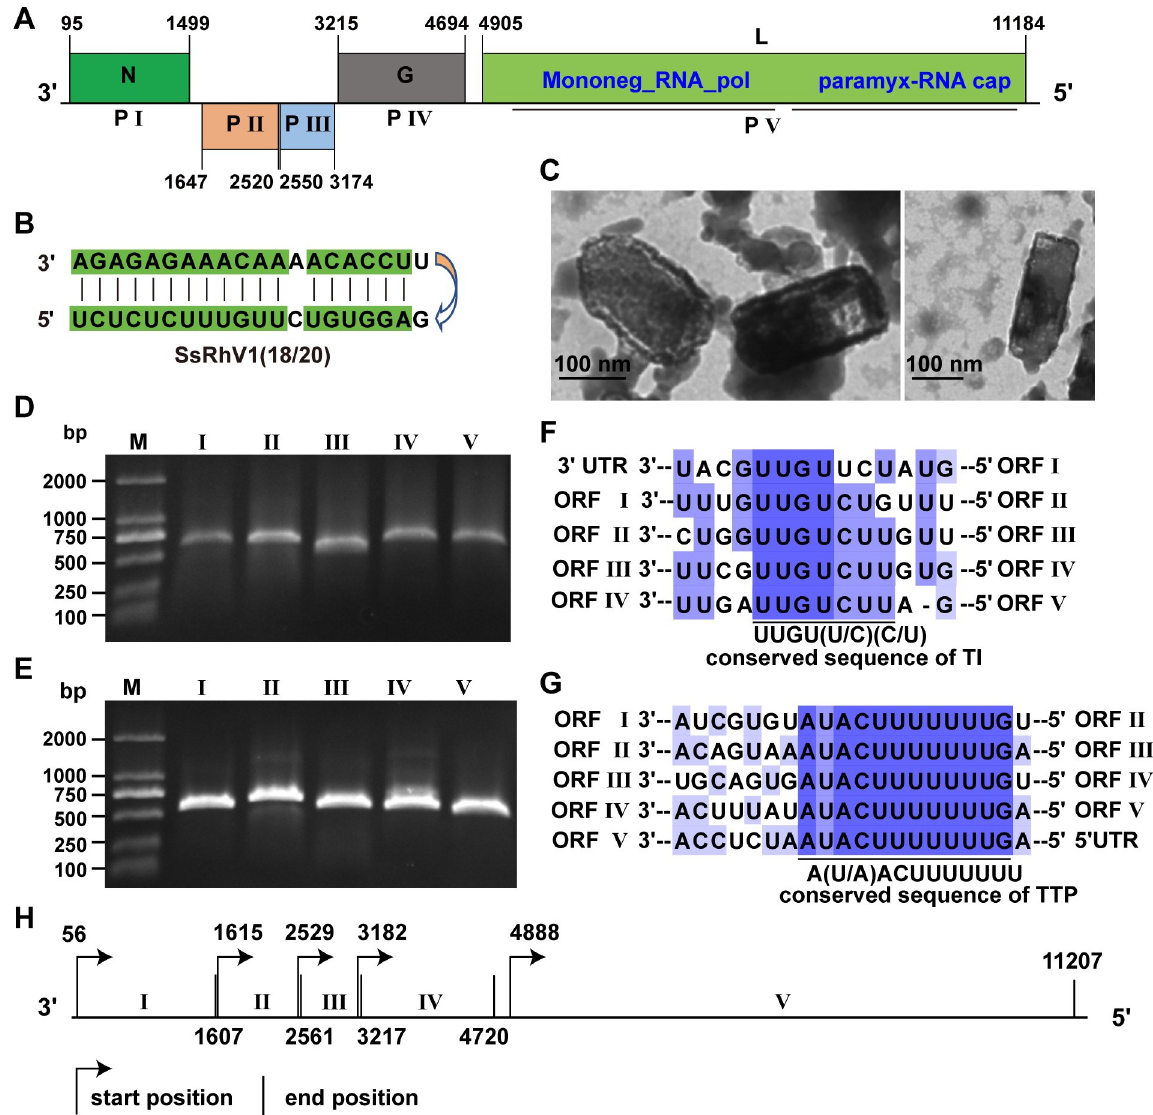
Fig 4. Genomic organization of SsRhV1. (A) Genome size and organization of SsRhV1. ORFs I, IV and ORF V are in the same frame, whereas ORF II and ORF III are in another frame. Boxes on the genome indicate the position and size of each ORF, which are labeled with Roman numerals. (B) The 3 0 leader and 5 0 trailer sequences of the SsRhV1 show terminal complementarity. (C) Morphology and structure of SsRhV1 particles. Particles were purified from mycelia of strain SX276 and negatively stained with 2% PTA [(wt/vol), pH 7.4]. (D) Agarose gel electrophoresis of the 5 0 RACE of ORFs I-V on 1% agarose gel. (E) Agarose gel electrophoresis of the 3 0 RACE of ORFs I-V on 1% agarose gel. (F) Comparison of transcription initiation (TI) signal between the ORFs in SsRhV1. The alignment of the transcription initiation sequences is shown in a 3 0 to 5 0 orientation. Conserved sequences are highlighted in purple. Different shades indicate the levels of conserved sequence, and the darkest color shade shows the most conserved sequence. (G) Comparison of transcription termination/polyadenylation (TTP) signal between the ORFs in SsRhV1. The alignment of the transcription termination/polyadenylation sequence is shown in a 3 0 to 5 0 orientation. (G) The possible transcript map of SsRhV1 based on the 5 0 and 3 0 RACE. 2093-aa protein (L protein). This protein has a 35% identity to the L protein of the Piry virus in the genus Vesiculovirus (S3 Table). The L protein of SsRhV1 contains two conserved domains (Fig 4A): one is Mononeg_RNA_pol (pfam00946), a typical conserved domain of members in the order Mononegavirales [39], and another, paramyx_RNAcap (TIGR04198), which is vital for the formation of the mRNA cap structures [40]. Thus, ORFs I, IV, and V of